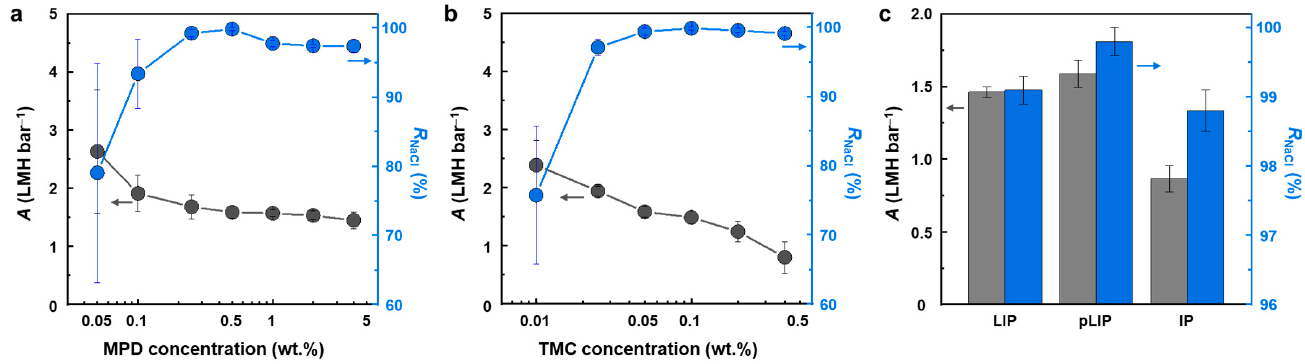
Figure 3. Surface morphologies and RO performance of the PIPA interlayers prepared with various TMC concentrations. ( a – d ) SEM surface images and ( e ) water permeance ( A ) and NaCl rejection ( R NaCl ) of the PIPA interlayers prepared at 0.5 wt.% PIP with different TMC concentrations: ( a ) 0.01, ( b ) 0.1, ( c ) 0.5, and ( d ) 1.0 wt.% TMC.